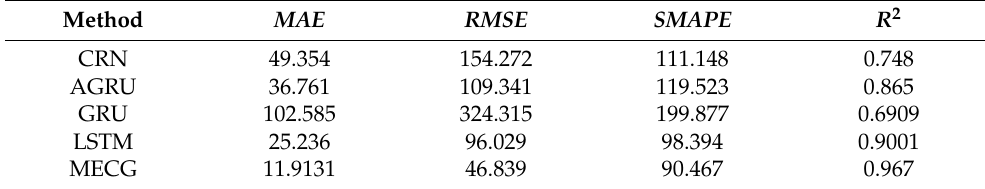
Table 3. Comparison between traditional deep learning model and MECG model.